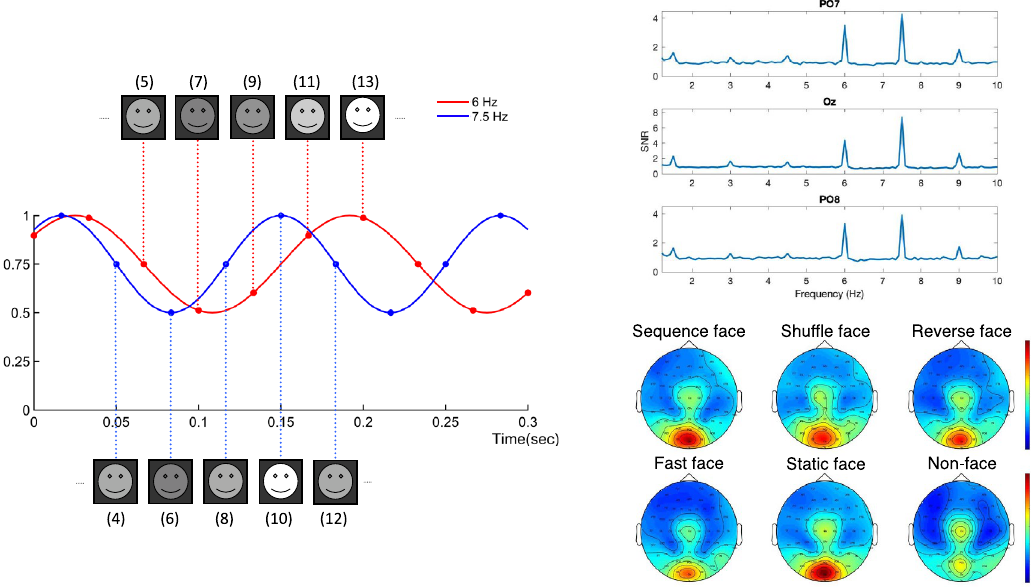
Figure 1. Schematic explanation of the interlaced frequency tagging approach. Left: Temporally interlaced frequency tagging (with f 1 = 6 Hz and f 2 = 7.5 Hz). In this tagging approach, the even and odd frames are sinusoidally contrast modulated (between mid-grey and white) at two different frequencies. The even frames are changing their contrast at 7.5 Hz (moving along the blue sine wave) while odd frames are changing their contrast at 6 Hz (moving along the red sine wave). Top Right: Average response across all conditions. The interlaced frequency tagging yields strong fundamental/harmonic ( nf 1 and mf 2 ) components. In the SNR spectrum, we observe not only prominent fundamentals and harmonics but also intermodulation components (IMs: nf 1 ± mf 2 ), which are specifically designed to measure the temporal integration processing during dynamic face perception. Bottom Right: Topographical distributions for the average SNR of the fundamental components. To generate the topographical map, we averaged the fundamental components ( f 1 and f 2 ) separately for each condition for each